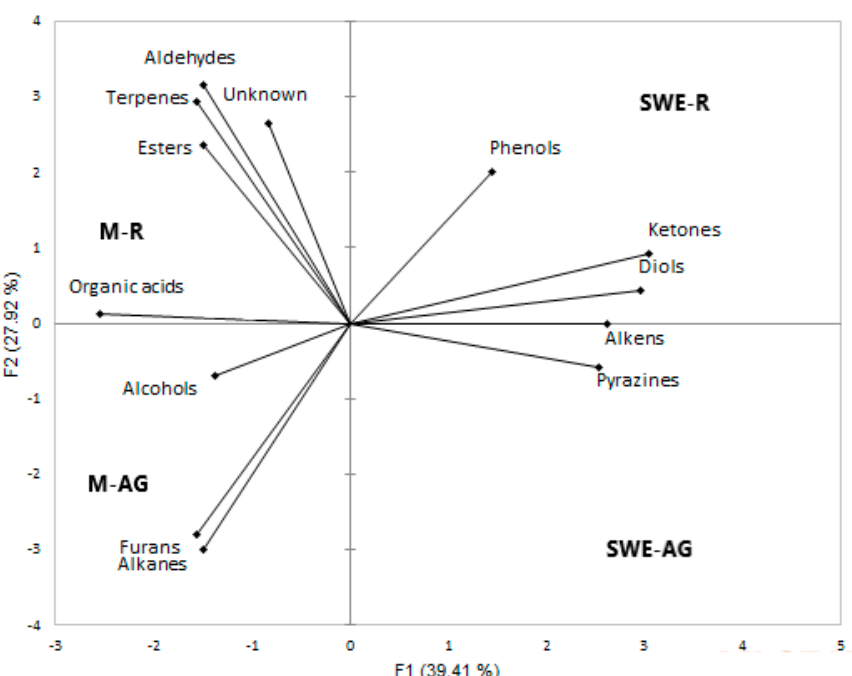
Figure 3. PCA of the main classes of compounds identified. M-AG: maceration aboveground part, SWE-R: subcritical water extraction roots, M-R: maceration roots, SWE-AG subcritical water extraction aboveground part.